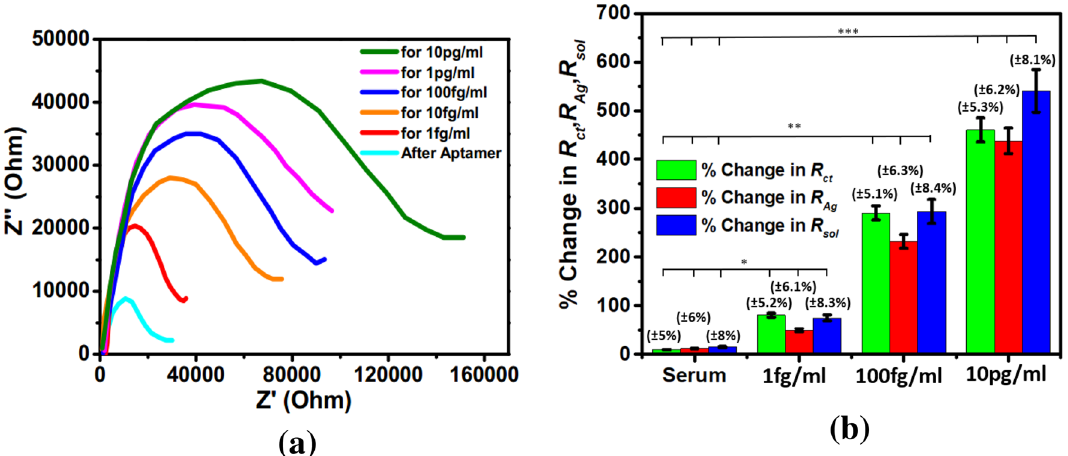
Figure 10. ( a ) EIS of Graphene-ZnO sensor electrode before and after capture of 1 fg/ml to 10 pg/ml of CEA in serum with external pulses of + 0.8 V. (graph indicates mean values with maximum standard deviations of ± 6.2%). ( b ) Percentage change in Rct, Rsol and RAg with different CEA concentration in serum. Error bars represent the standard deviation. Statistical analysis (ANOVA) shows significant difference with blank serum. (* p < 0.01, ** p < 0.001, *** p < 0.0001). Electrode materials Linear